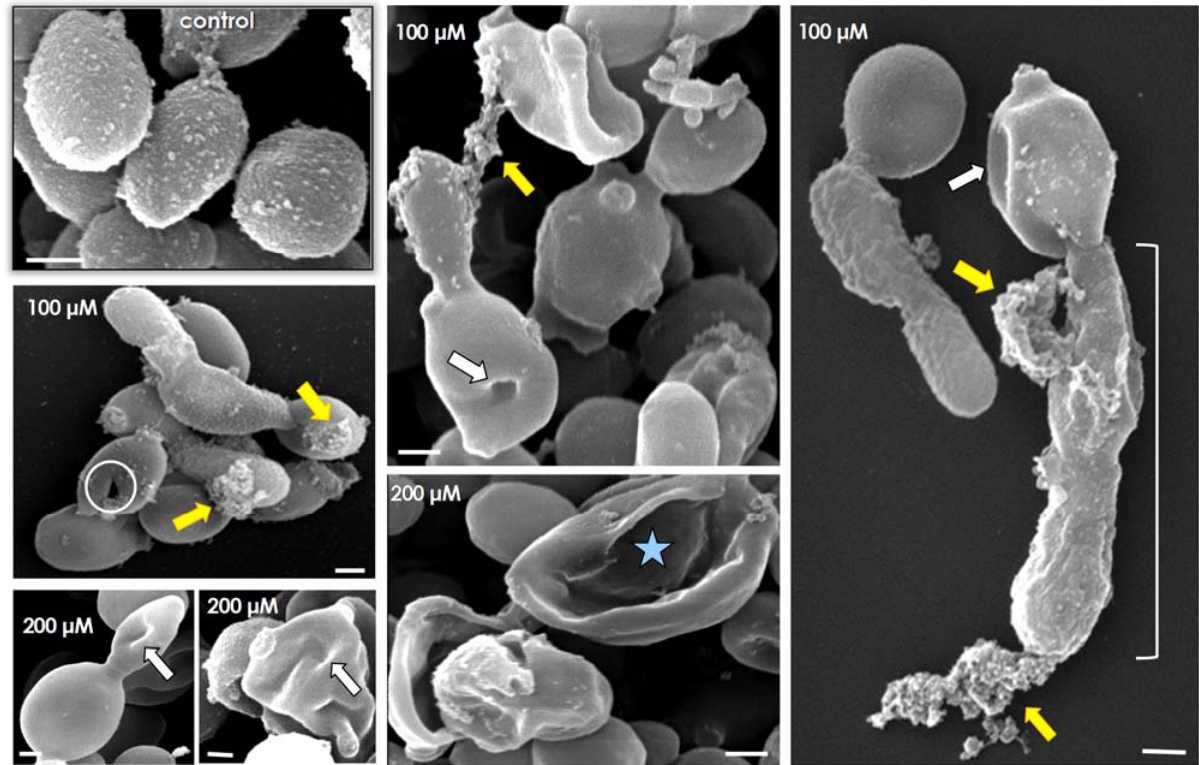
Figure 5. Effects of lopinavir on the ultrastructure of C. albicans cells. Untreated and lopinavir (100 and 200 µM)-treated fungal cells were processed and analyzed by scanning electron microscopy. Control cells are characterized by oval-to-round cells with a rough surface, covered by several protrusions. The treatment with lopinavir promoted (i) the detachment of surface materials from the cell wall in both yeasts and filamentous (delimited by brackets) as indicated by yellow arrows; (ii) the conversion of rough surface to smooth one; (iii) surface invaginations in both yeast and daughter cells (white arrows); (iv) alterations on yeast shape, some of them with altered surface sculpturing and (v) lysis of fungal cells (white circle and blue star). Bars = 0.5 µm.